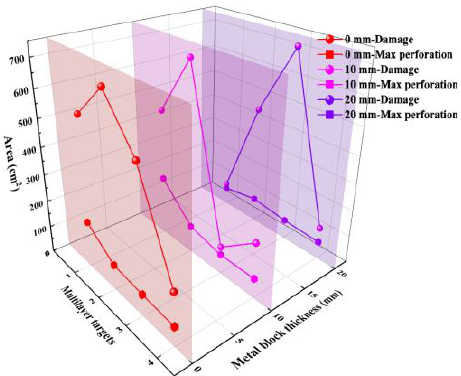
Figure 14. Damage results of MLAT with different metal block thicknesses.